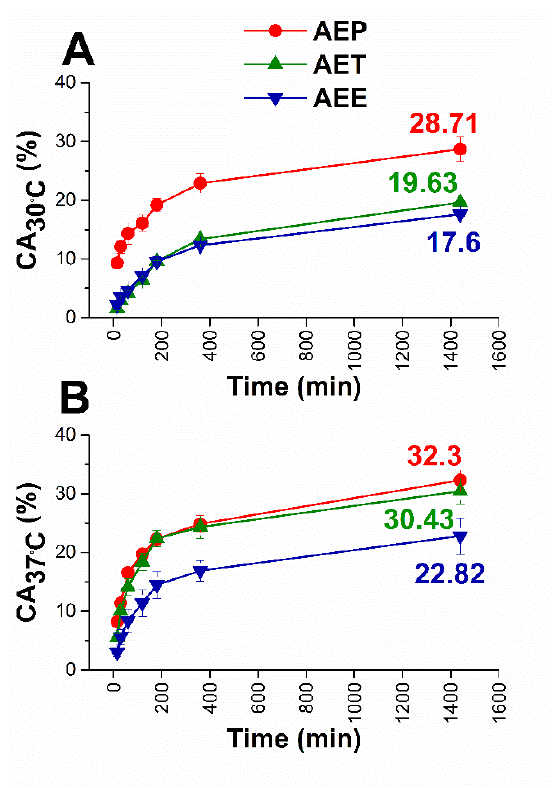
Figure 1. Results of in vitro diffusion studies through agar gel membrane as biofilm model for AEE, AET, and AEP at 30 °C ( A ) and 37 °C ( B ), respectively. The AE concentration is 200 µg/mL. CA: cumulative amounts of essential oil in percentage; the experiments were performed in triplicate (mean ± SD).